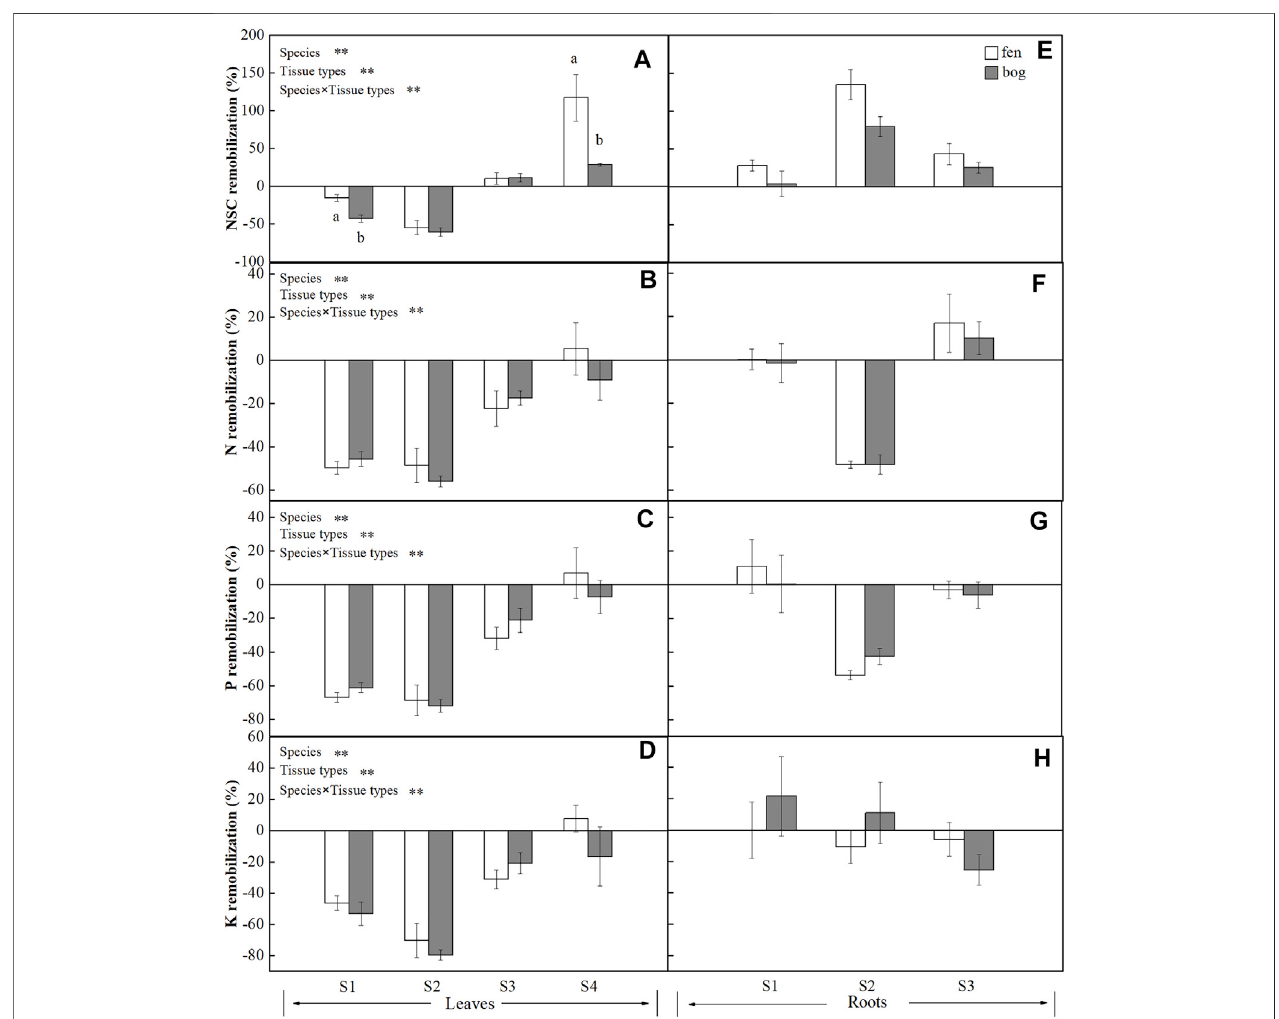
FIGURE 3 | Remobilization ef fi ciency (mean ± SE; % of dry matter) of NSC, N, P, and K in leaves and roots of plants grown in fens ( n = 5) and bogs ( n = 4). Different lowercase letters display signi fi cant differences between fens and bogs for each species within each time, tested with t -test ( p < 0.05). S1 – S4 represent B. fruticosa , P. australis , C. lasiocarpa, and S. magellanicum , respectively.